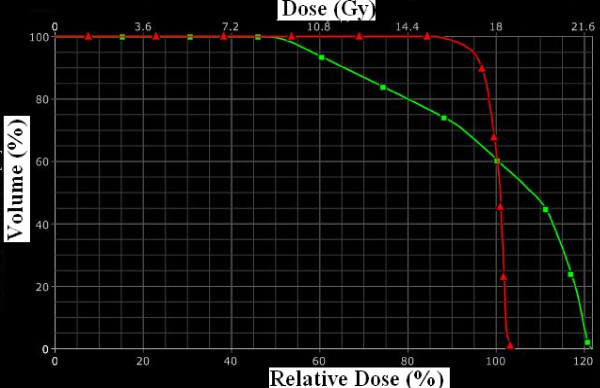
Histogram-Dose Volume according to the treatment received. Green: hemibrain irradiation. Red: whole brain irradiation.